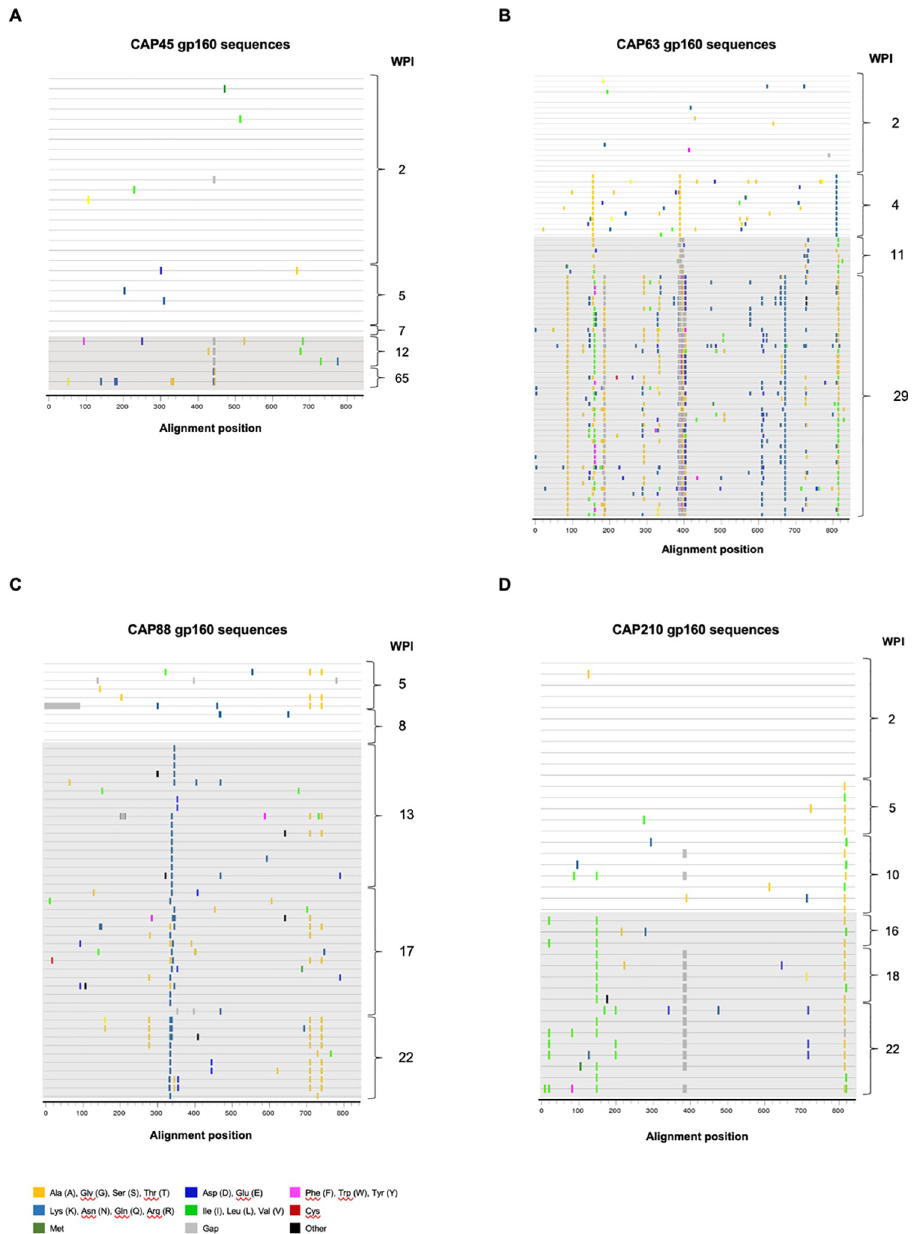
Fig 4. Highlighter amino acid plots showing viral evolution of the HIV-1 envelope in five CAPRISA 002 participants. Full-length env sequences were generated over time for five CAPRISA 002 participants. In CAP45, 31 single genome sequences were obtained from five time-points over 1 year of infection (A) ; in CAP63, 84 single genome sequences were obtained from four time-points over six months of infection (B) ; in CAP88, 52 single genome sequences were obtained from five time-points over six months of infection (C) ; and lastly, in CAP210, 39 single genome sequences were obtained from six time-points over six months of infection (D) . The presence of detectable nAbs is indicated by grey shading. The reference sequence for each participant is the respective T/F